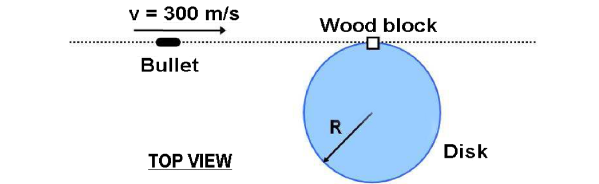
FIG. 6 (color online). A synthesis problem on the final exami- nation. A formula for the moment of inertia of the disk ( I ¼ 1 = 2 mR 2 ) was given to students on a separate formula sheet. All students directly solved this problem without receiving scaffold- ing or other hints.